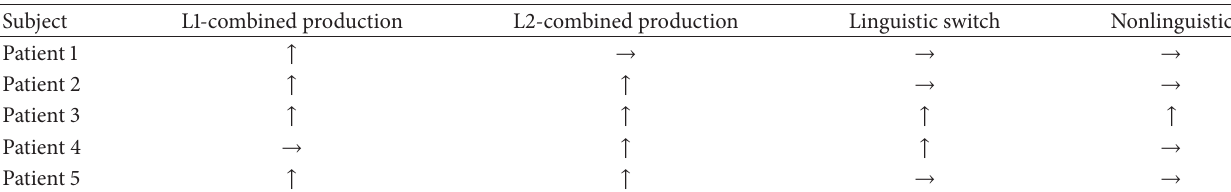
Table 4: Summary of the recovery